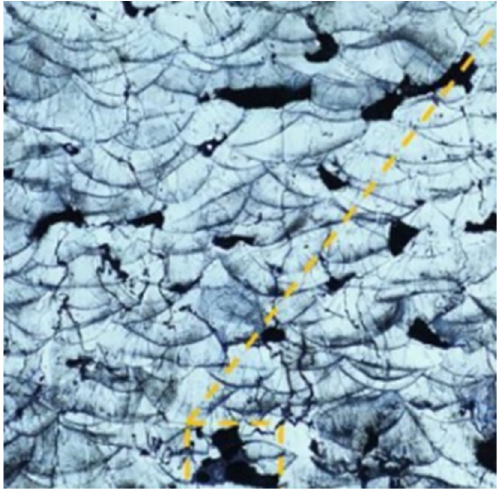
Figure 9. Lack of fusion pores morphology [16].